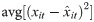
Performance of full EM algorithm on working memory model.(A) Log-likelihood as a function of EM iteration for the highest-likelihood run out of all 240 initializations. As in this example, the log-likelihood, although generally increasing, was not always monotonic (note the little ripples; see discussion in Results). (B) Mean squared prediction error, avg[(xit−x^it)2], between true ({xt}) and predicted ({x⌢t}) observations across all 20 output variables and the 5 highest-likelihood solutions, as a function of ahead-prediction time step Δt, for the original PLRNN (blue curve) and for a linear dynamical system (LDS; red curve) estimated via EM from the same, PLRNN-generated data. Note that while the true and estimated observations agree almost perfectly for both the PLRNN and LDS if predicted directly from the inferred states (i.e., x⌢t=Bϕ(z^t)), prediction quality severely decays for the LDS while remaining high for the PLRNN if {x⌢t}-predictions were made from states forecast Δt time steps into the future (see text for further explanation; note that a slight decay in prediction quality across Δt is inevitable because of the process noise). Error bars = SEM.